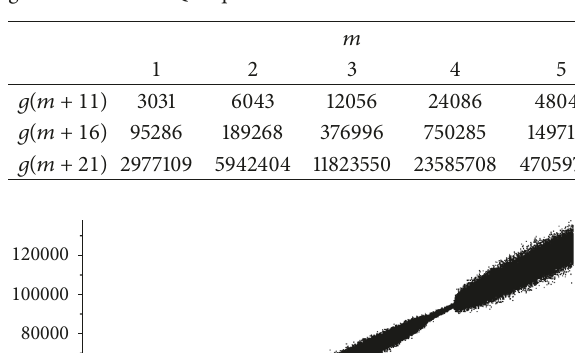
Table 1: The values of 𝑔(𝑘) that refer to the start points of maternal generations of the 𝑄 -sequence.